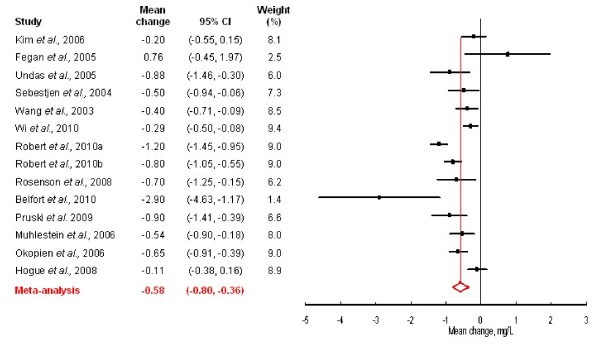
Forrest plot showing the change in C-reactive protein concentrations following treatment with fenofibrate.